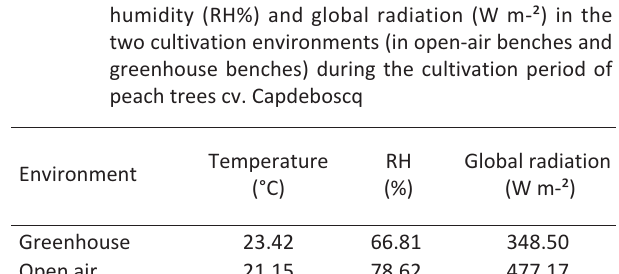
Table 3 ­ Summary of the variance analysis for contrasts between the environmental factors of cultivation and CRF (Osmocote®) doses for the variables stem diameter (SD), plant height (H), number of leaves per plant (NL), shoot dry matter (SDM), root dry matter (RDM), total dry matter (TDM), plant height and stem diameter (H/SD) ratio, and the Dickson Quality Index (DQI) of peach trees cv. Capdeboscq 90 days after transplantation